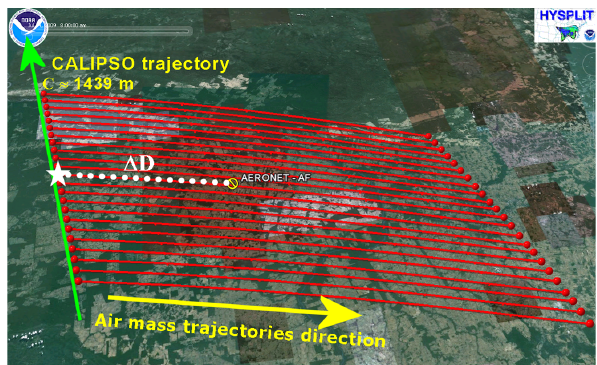
Table 5. Percentage of correlative measurements under free-cloud conditions selected for application of the AC method and subse- quent comparison to the optical properties retrieved by CALIOP and the AERONET sun